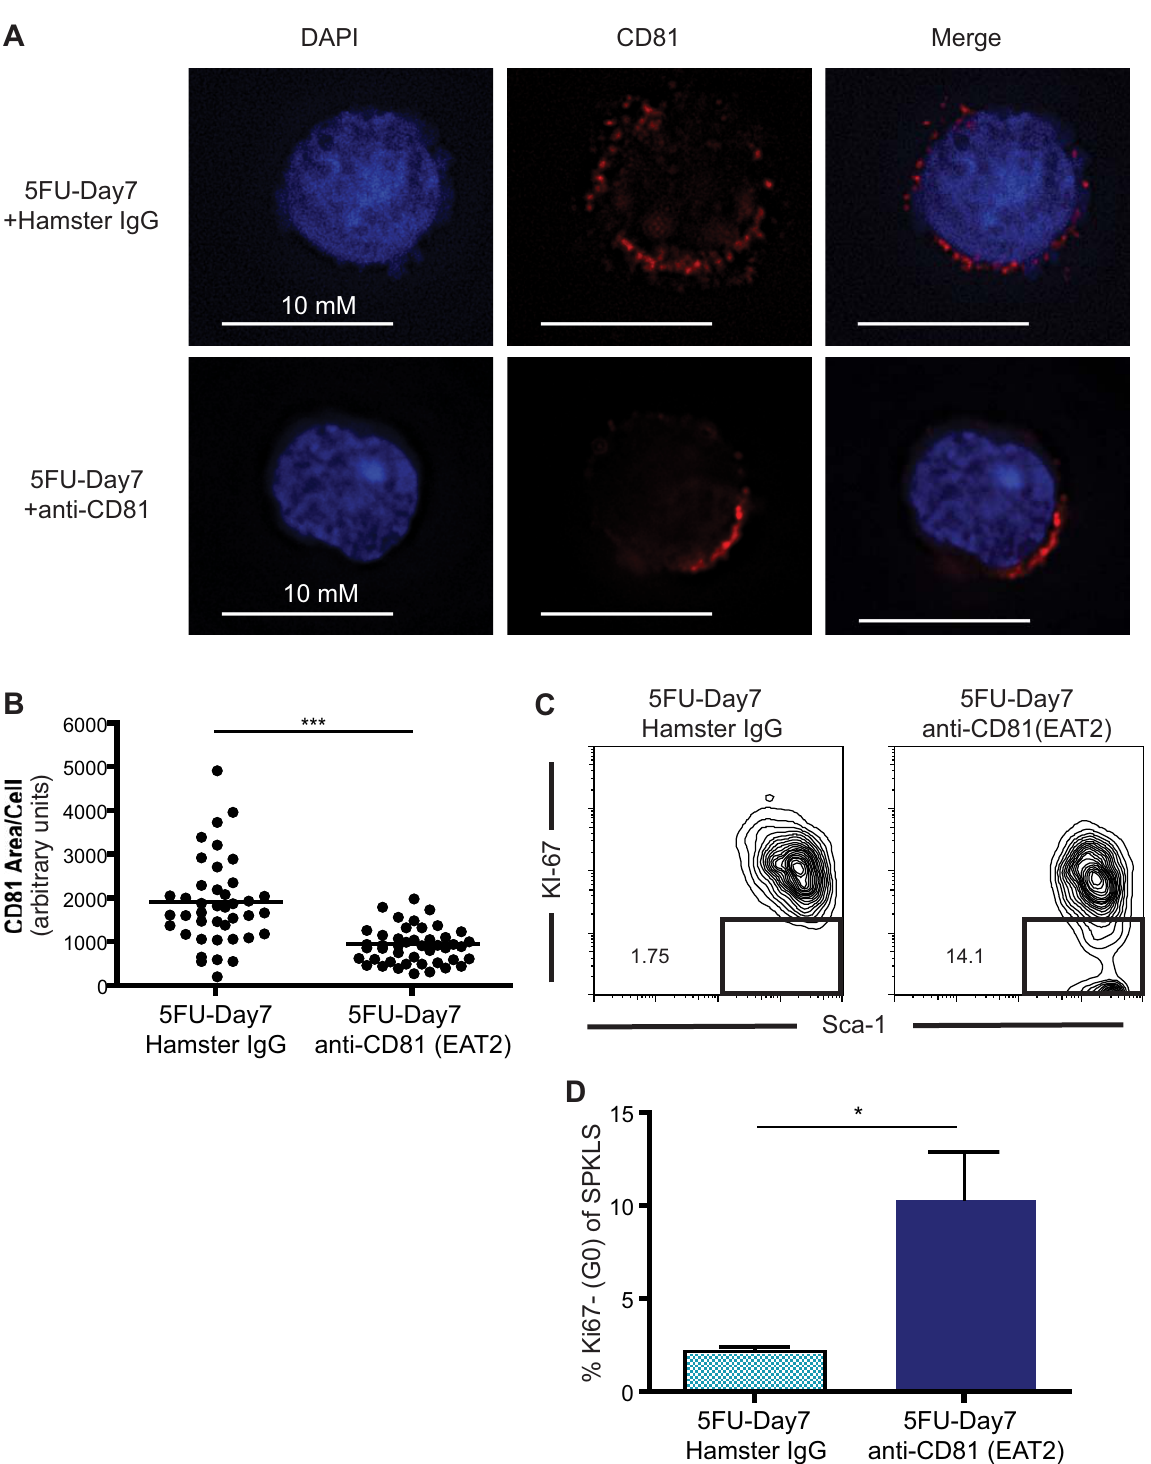
Figure 4. CD81 monoclonal antibody triggers early cell cycle exit . (A) EAT2, a CD81 monoclonal antibody, induces clustering of CD81 on regenerating HSCs (5FU-Day7). With CD81 antibody treatment, the localization of CD81 protein on the wild-type HSC cell membrane shows a distinctively polarized pattern; whereas with the isotype control antibody, the pattern consists of diffuse punctuate dots. (B) The distribution of CD81 on EAT2-treated HSCs is significantly compressed by comparison with the isotype control. In this assay, single cell images were acquired, and the area of CD81 in every acquired image was measured with ImageJ. Horizontal bars denote medium values. Mean values 6 SD are shown (*** p , 0.001). (C) Engagement of CD81 proteins on proliferating HSCs (5FU-Day7) with EAT2 induces a significant fraction of HSC to enter quiescence. Ki-67 staining was used to identify proliferating HSCs. Proportions of quiescent cells are given within the graph. (D) EAT2 induces cell cycle exit. HSCs stimulated with 5FU were treated with EAT2 or hamster IgG ( n =3 per group) and assessed for Ki-67 reactivity on day 7 post-treatment. Mean percentages 6 SD are shown (* p , 0.05).